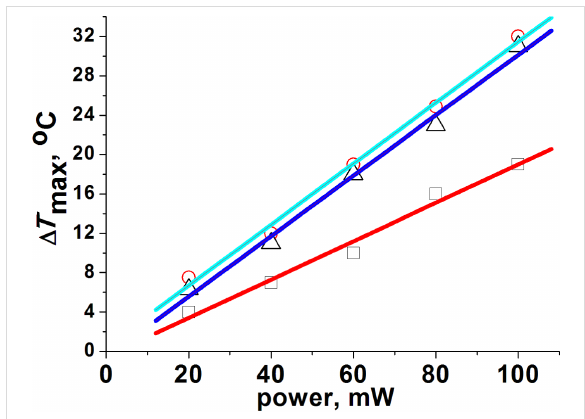
Figure 4: The photothermal effect ( Δ T ± 1.5 °C) of PVA-GNS films upon NIR irradiation at 1064 nm (open squares), 800 nm (open circles) and 730 nm (open triangles). The data are fit with a linear function (colored solid lines).The slopes ( b ) of the fitting curves ( y = a + bx ) are: b = 0.19 ± 0.01 °C/mW (1064 nm); b = 0.3 ± 0.1 °C/mW (800 nm); b = 0.3 ± 0.1 °C/mW (730 nm). Irradiation area ≈ 0.4 cm 2 .